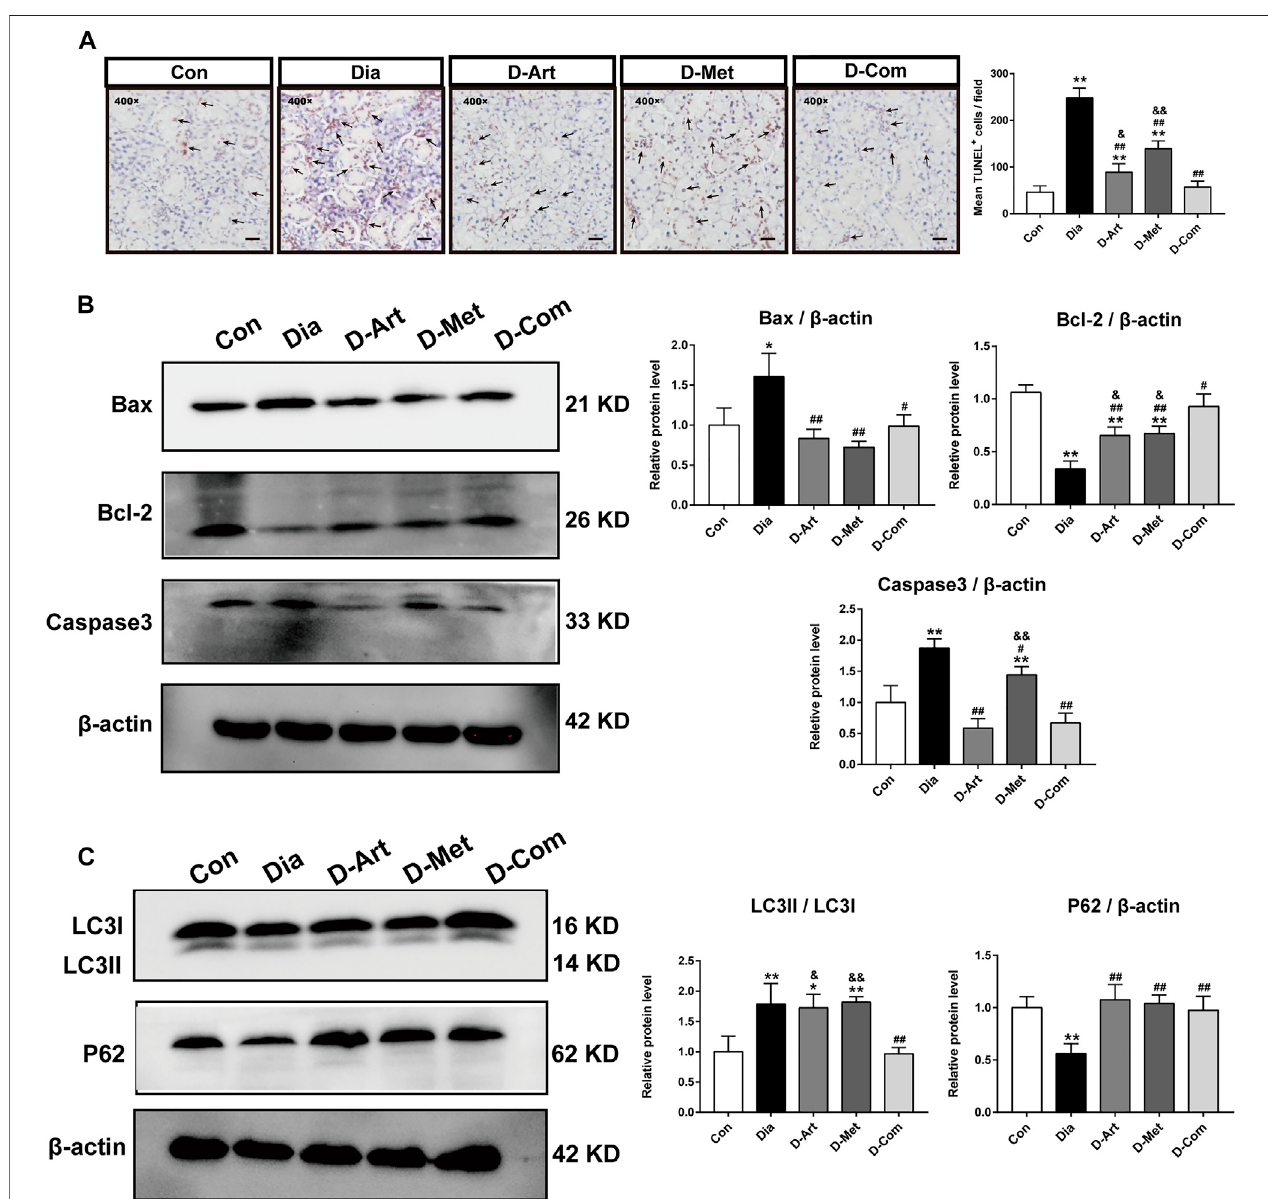
FIGURE 8 | ART or Met alone and ART/Met combination inhibit apoptosis and autophagy in the SMGs of T2DM rats. (A) TUNEL staining in SMGs. Black arrows display TUNEL positive cells. (B) Western blot analyses for Bax, Bcl-2, and Caspase3 protein expression in SMGs. (C) Western blot analyses for LC3 and P62 protein expression in SMGs (5 rats per group). Protein expression is normalized to β -actin. Data are expressed as the mean ± SD. * p < 0.05 and ** p < 0.01 versus Con group; # p < 0.05 and ## p < 0.01 versus Dia group; & p < 0.05 and && p < 0.01 versus D-Com group. Con, Normal control group; Dia, Untreated diabetic group; D-Art, ART-treated diabetic group; D-Met, Met-treated diabetic group; D-Com, ART/Met co-treated diabetic